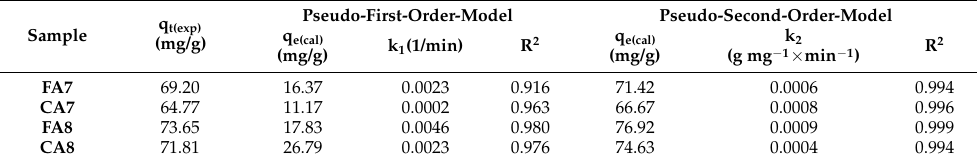
Figure 6. The effect of contact time of biocarbon with methyl red sodium salt (biocarbon mass: 25 mg, initial dye solution concentration: 40 mg/L, volume of methyl red sodium salt solution: 50 mL, temperature: 23 ± 1 °C).